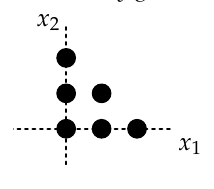
Visualization of a three-fat point in P 2 : each dot corresponds to a generator of the local ring, which is